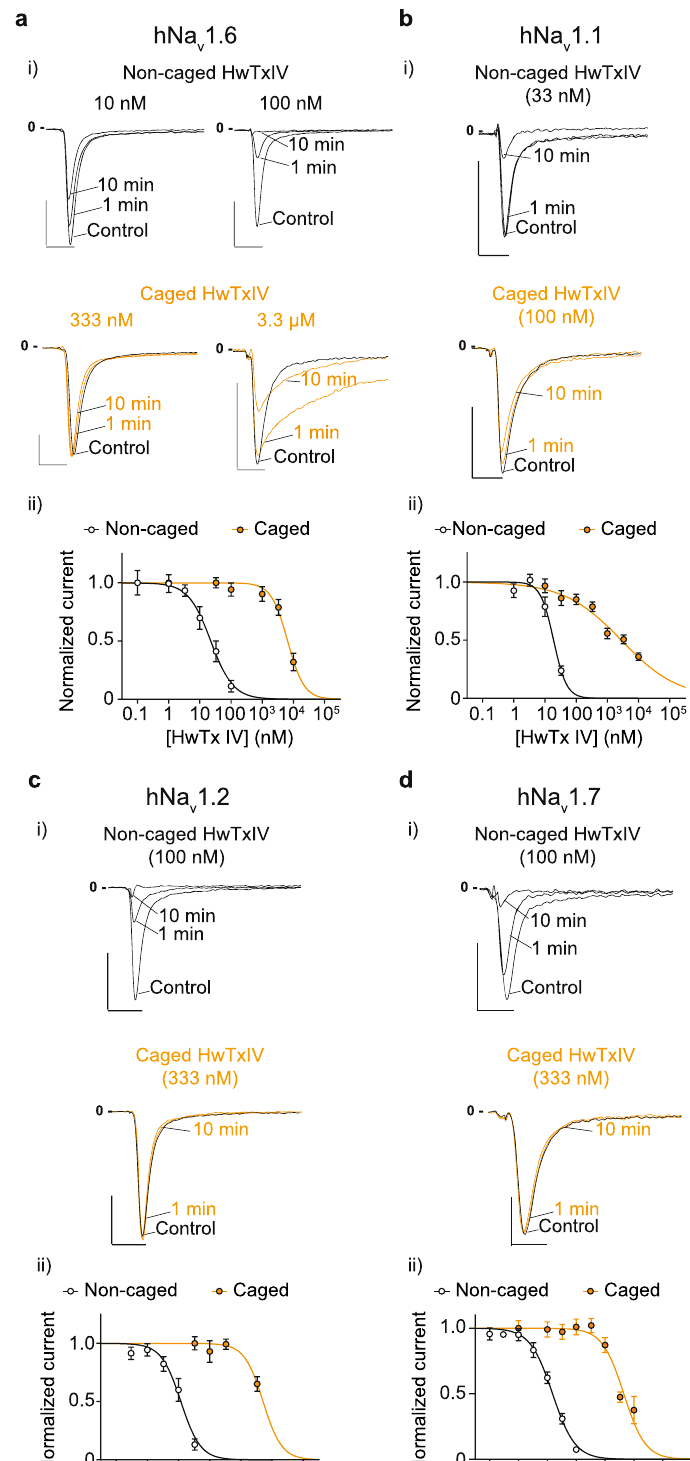
indicating different orientations of the Nvoc protecting group. HwTxIV-Nvoc showed excellent dark stability in solution for over 1 week (Supplementary Fig. 2). HwTxIV-Nvoc drastically reduces the potency of the peptide for Na V channels . Next we validated functionally that the steric